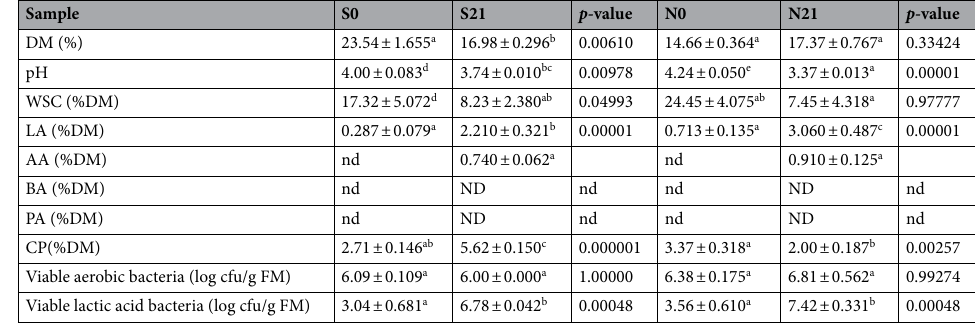
Table 1. Fermentation characteristics of sweet corn and Napier before and after ensiling for 21 days. S0 fresh sweet corn, S21 sweet corn silage, N0 fresh Napier, N21 Napier silage, DM dry matter, WSC water-soluble carbohydrates, LA lactic acid, AA acetic acid, BA butyric acid, PA propionic acid, CP crude protein, FM fresh materials, nd not determined, ND not detected. Values in the same row followed by different letters are significantly different ( p -value <